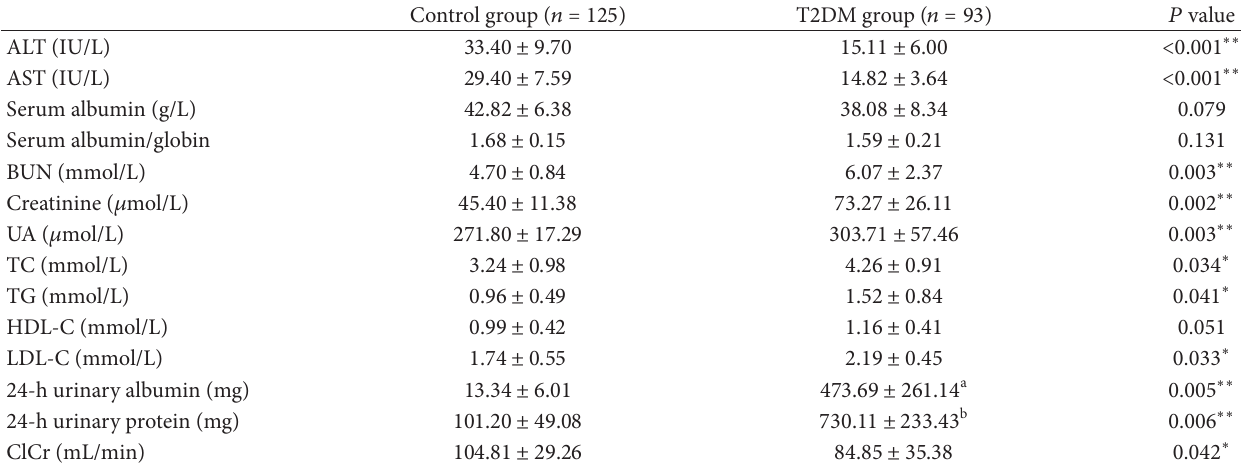
T 4: Laboratory test results of patients with T2DM and the control subjects.